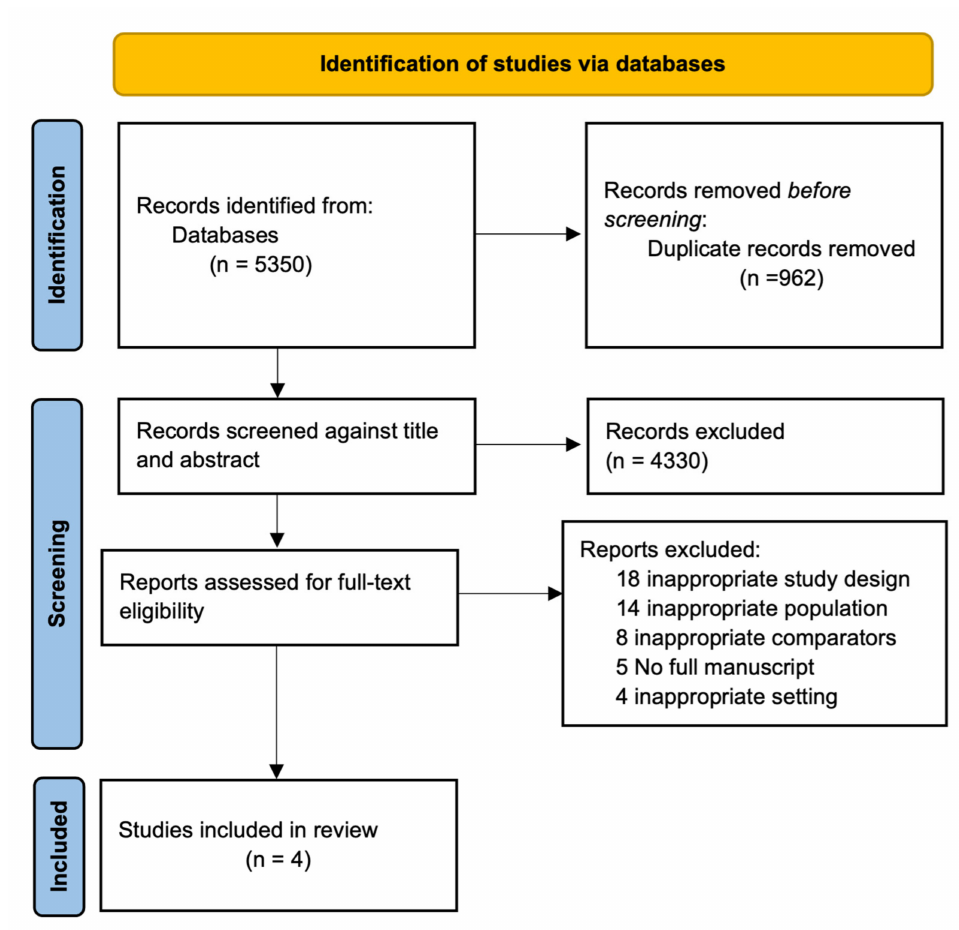
Figure 2. PRISMA 2020 flow diagram for the systematic